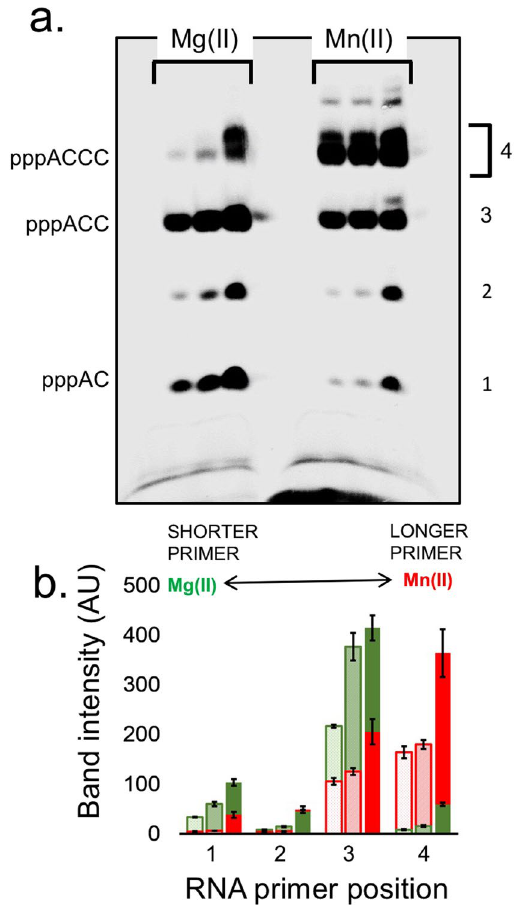
Figure 2. Template-directed oligoribonucleotide synthesis catalyzed by T7 DNA primase. ( a ) The reaction contained the oligonucleotide 5 ′ -GGGTCA 10 -3 ′ with the primase recognition sequence and [ α - 33 P]-CTP and ATP in the standard reaction mixture in the presence of 8 mM MgCl 2 or 8 mM MnCl 2 in a reaction buffer containing increasing amounts of T7 DNA primase (0, 1.11, 3.33, and 10 µ M). After incubation for 20 min at RT, the radioactive products were analyzed by electrophoresis through a 25% polyacrylamide gel containing 7 M urea and visualized using autoradiography. ( b ) Quantification of primase activity. The bands in the gel presented in a were analyzed using